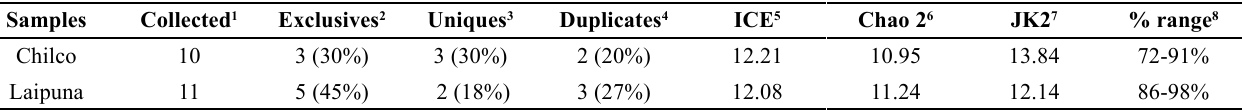
Table 2. Pitfall trap alpha diversity for sampled sites. 1 - total species collected in each transect, 2 - species collected only in that transect, 3 - species collected in only one quadrat (0.05) and their proportion relative the total number of species for the transect, 4 - species collected in two quadrats (0.10) and their proportion relative the total number of species for the transect. Species richness according to the following estimators: 5 - ICE, 6 - Chao 2, 7 - Jackknife 2; 8 - minimum and maximum values of the proportion of observed species according to the estimators. Samples